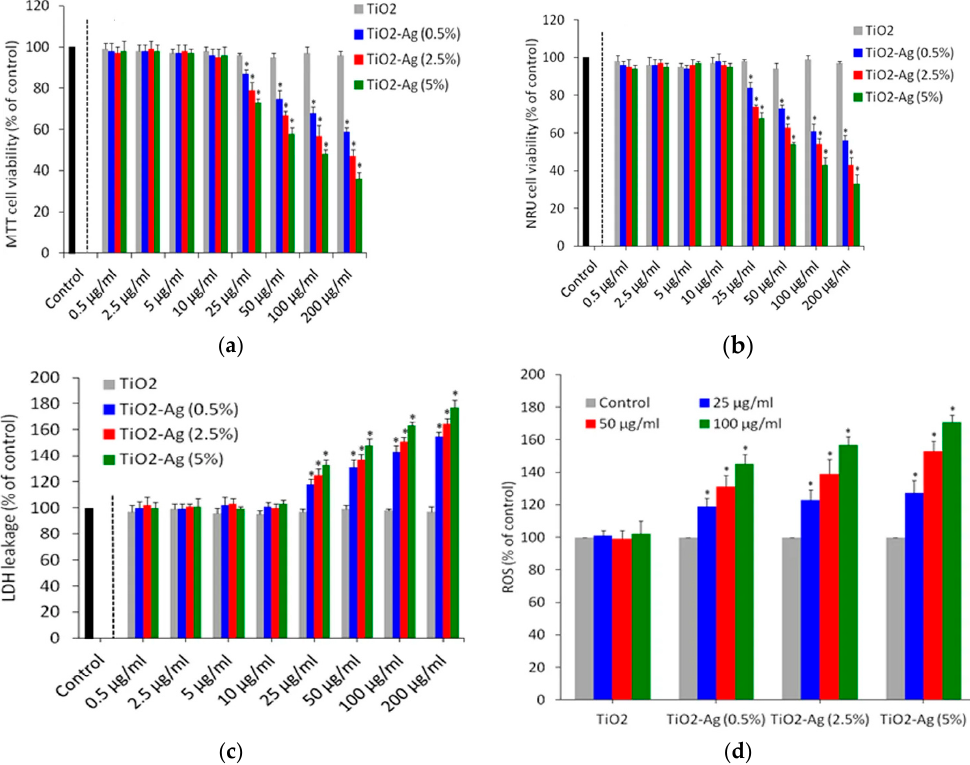
Figure 34. ( a ) MTT, ( b ) NRU, and ( c ) lactase dehydrogenase leakage results of human liver cancer (HepG2) cells exposed to TiO 2 NPs and Ag-doped TiO 2 NPs of different concentrations. ( d ) ROS level of HepG2 cells exposed to pure TiO 2 NPs and Ag-doped TiO 2 NPs of 25, 50 and 100 µg/mL. Reproduced with permission from [318], Copyright Nature Publishing Group, 2017.